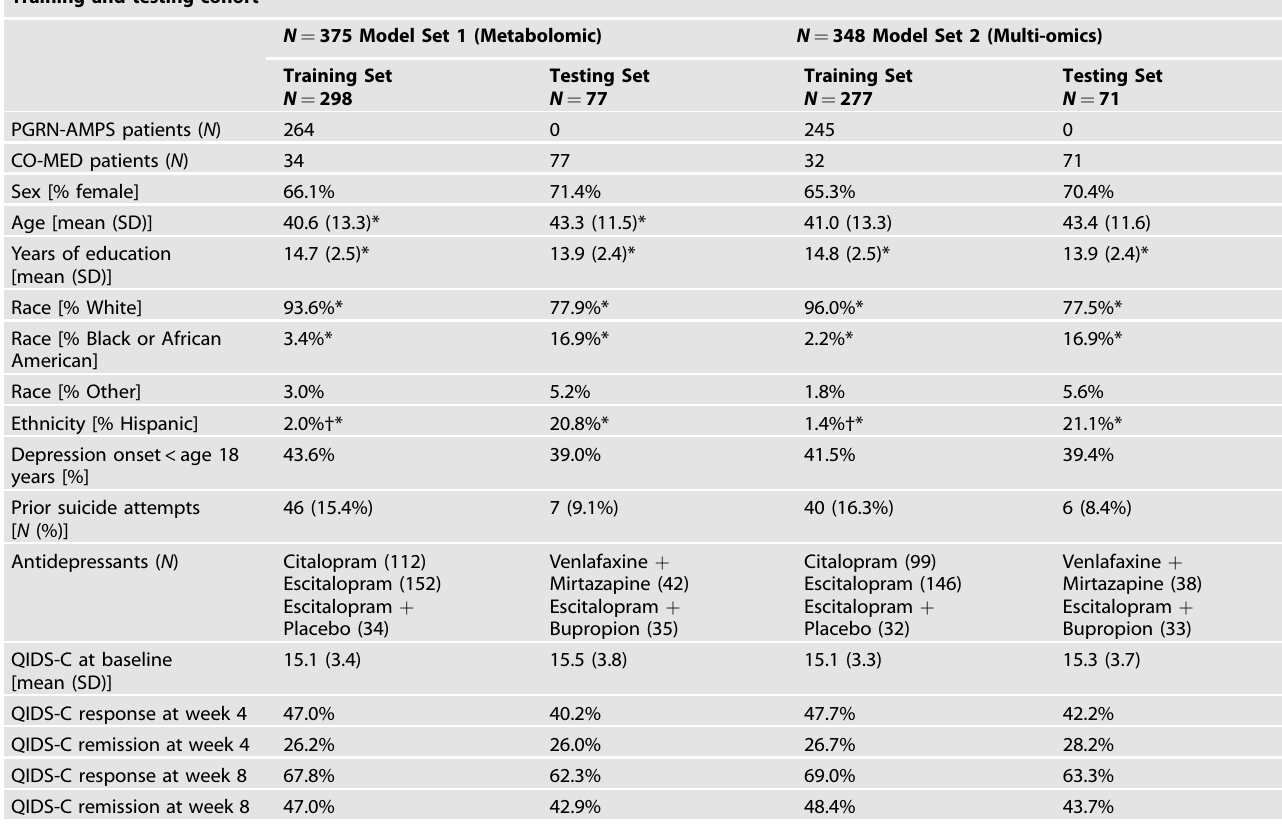
Table 1. Clinical and sociodemographic features of training and testing